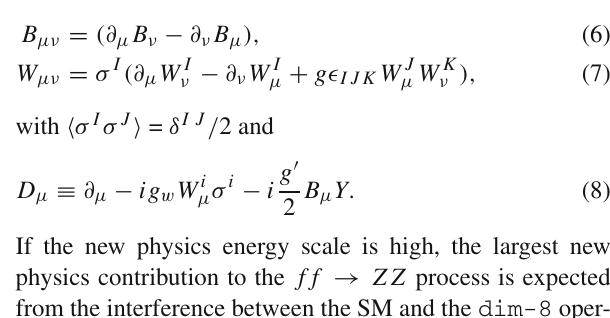
Table 1 Observed one dimensional 95% confidence level (C.L.) limits on C